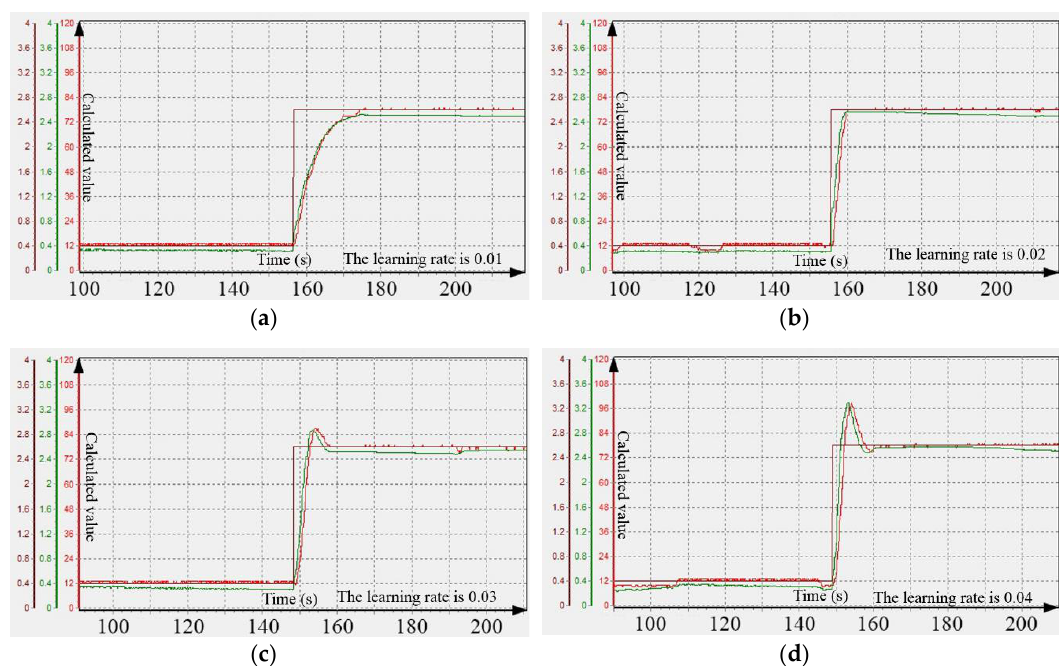
Figure 14. Comparison of step control performance under different learning rates. (a) Performance